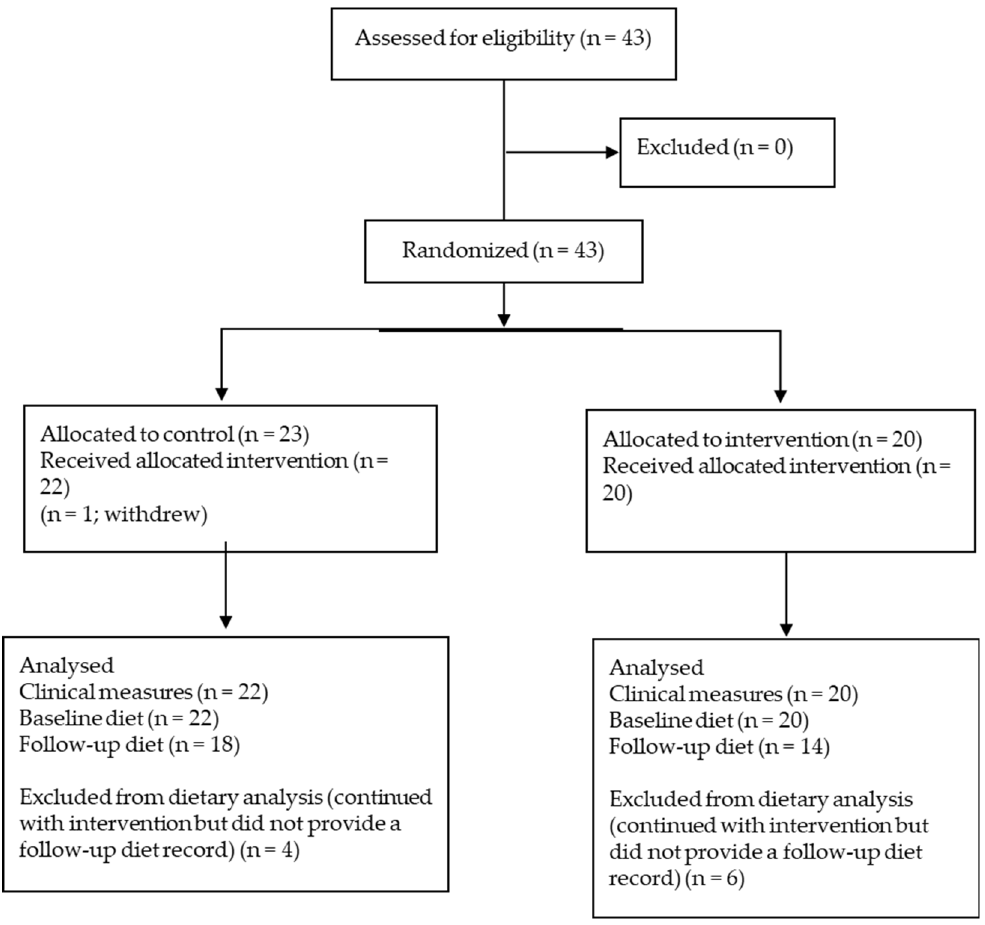
Figure 2. Flow of participants. Table 1. Demographic characteristics by randomised group (n = 43).